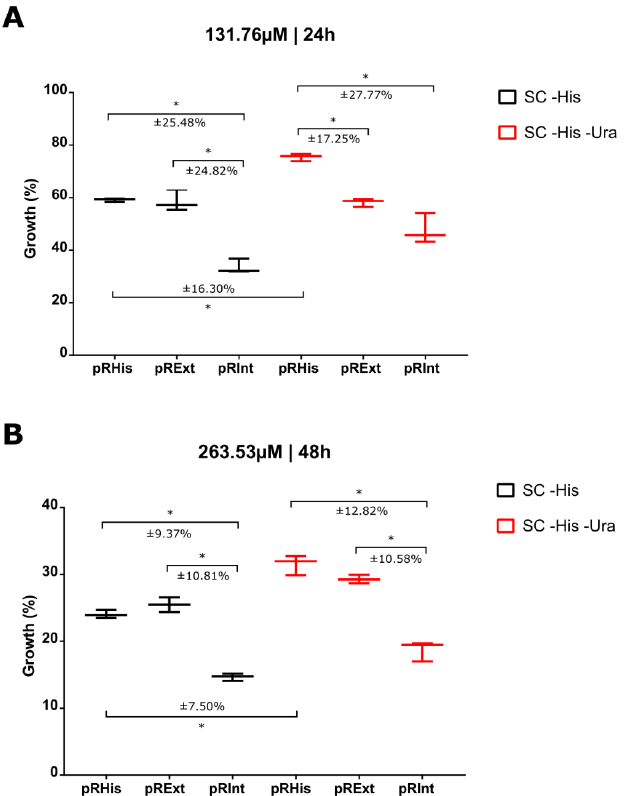
Figure 6. Impact of cisplatin on the growth of S. cerevisiae containing the CnePrp8i in the URA3 gene (pRInt) in the SC -His and SC -His -Ura media. The growth was compared with S. cerevisiae controls ( URA3 gene without the CnePrp8i, pRHis and pRExt). Points of greatest growth difference between the constructs under cisplatin availability ( A ) at 131.76 μM after 24 h growth and ( B ) at 263.53 μM after 48 h growth. (* Tukey ′ s HSD test p <